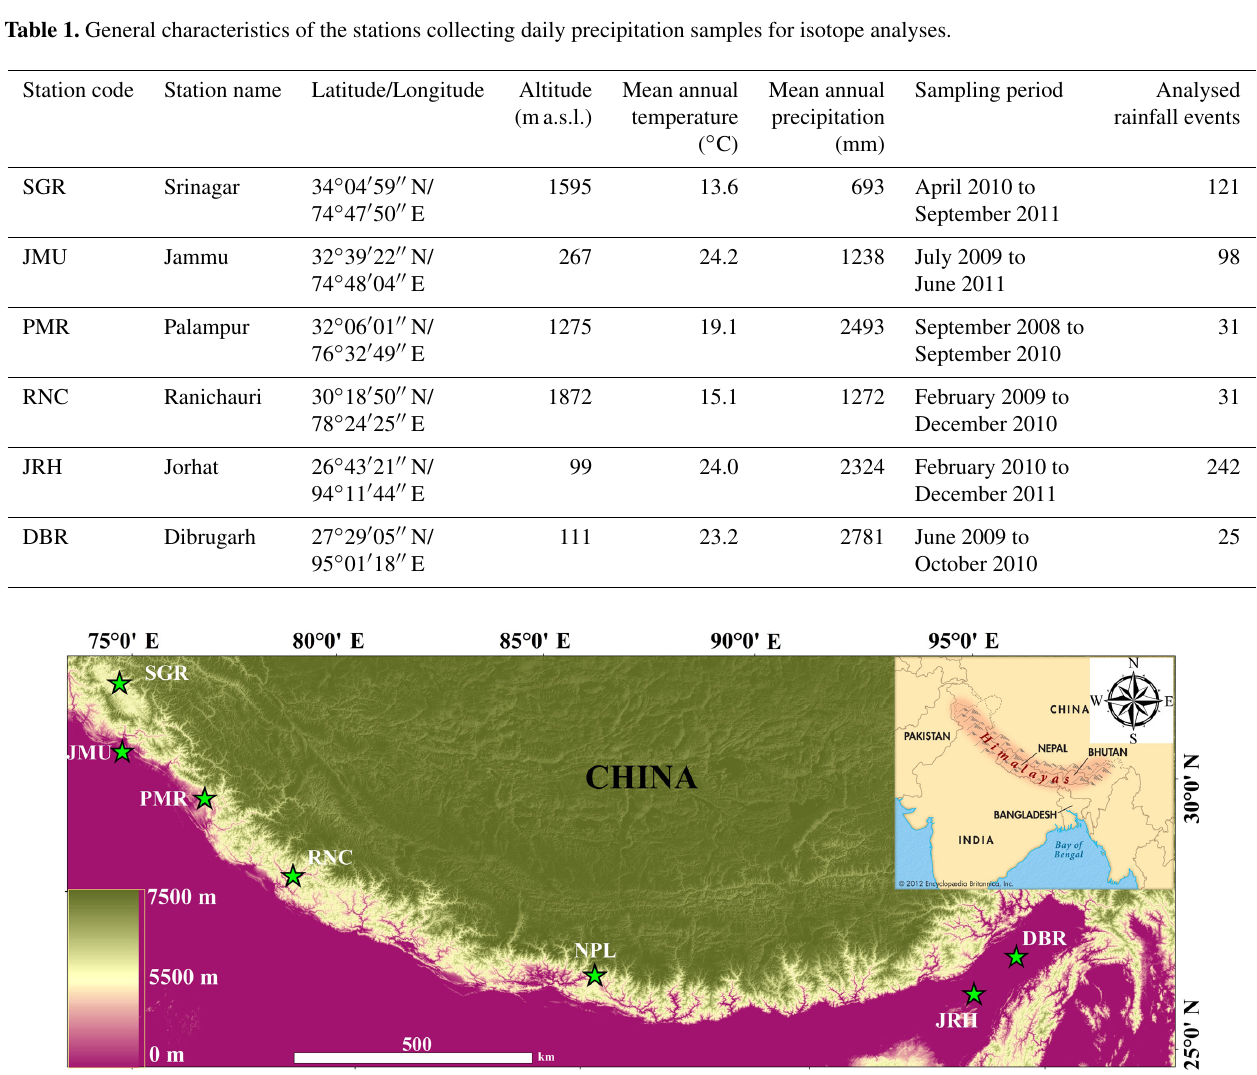
Figure 1. Locations of the six sampling sites across the southern foothills of the Himalayas: SGR – Srinagar, JMU – Jammu, PMR – Palampur, RNC – Ranichauri, JRH – Jorhat and DBR – Dibrugarh. The position of the Kathmandu station, Nepal (NPL), which is discussed in the text, is also marked in the